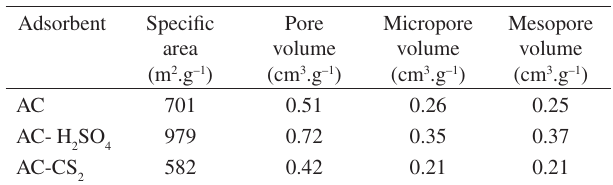
Table 2. Textural parameters of the